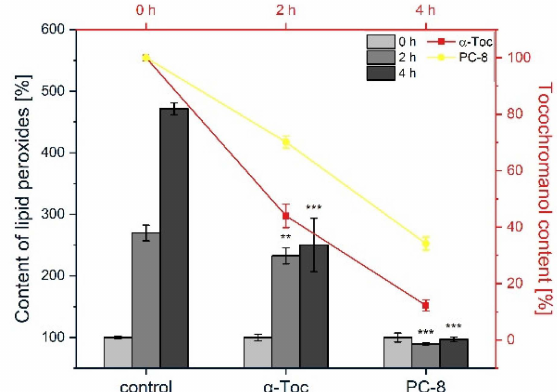
Figure 3. The effect of PC-8 on the rate of the formation of lipid peroxides in plant lipid liposomes initiated by AMVN ( bars ). Time-course of PC-8 decay during the peroxidation reaction ( lines ). The reactions were conducted at 37 ◦ C. The data are means SEM ( n = 3). Asterisks indicate statistically ± significant differences compared with control at corresponding time point (** p < 0.01, *** p < 0.001; one-way ANOVA followed by Duncan’s post hoc